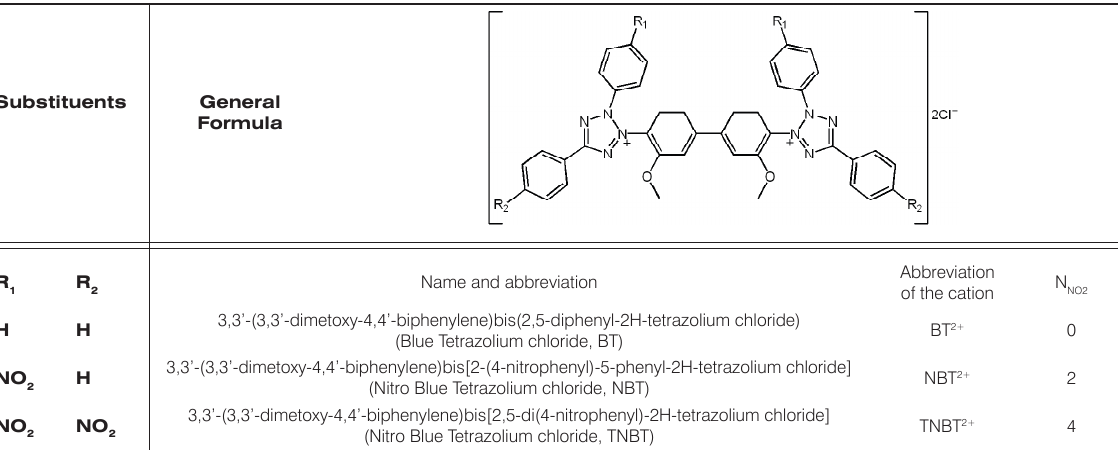
Table 1. Phenylmethoxybis(tetrazolium) salts (MBT) in the present study.